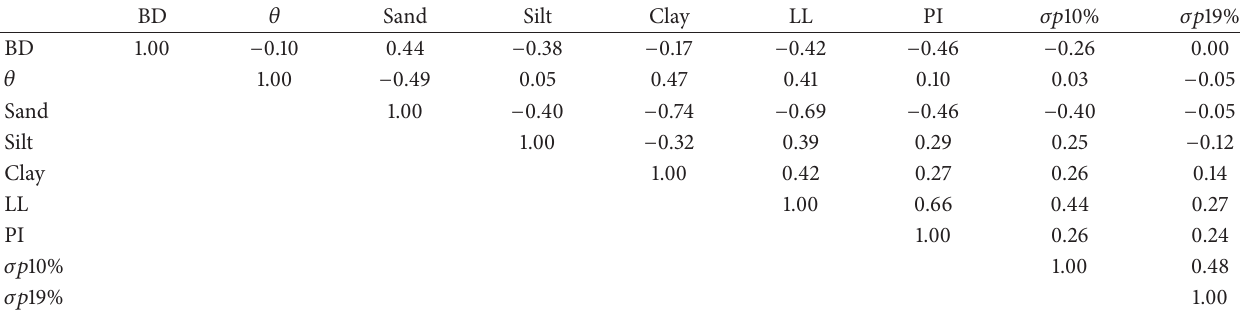
Table 4: Matrix linear correlation between the physical and mechanical soil